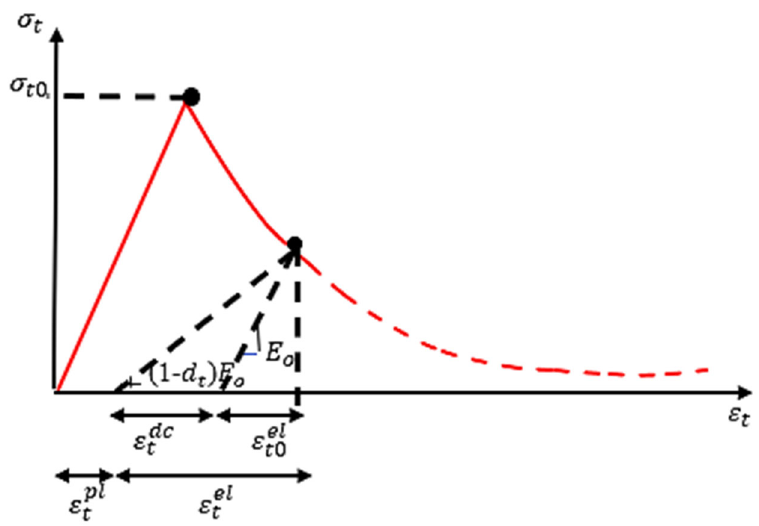
Figure 2. Stress ‐ strain relationship of concrete under the effect of tensile stress. Figure 2. Stress-strain relationship of concrete under the effect of tensile stress.